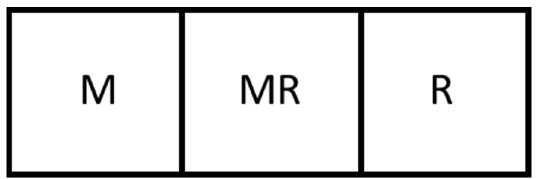
Figure 1. An example arrangement of three modules to make a larger intensified unit. Here a membrane separator (M), a membrane reactor (MR), and a reactor (R) are combined.